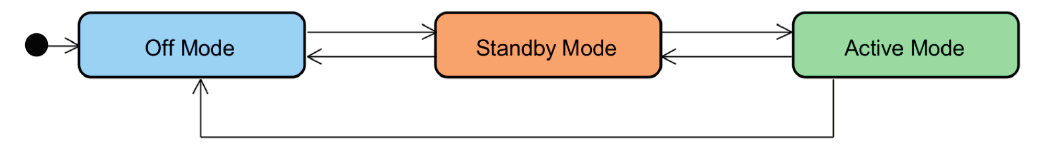
Figure 5. Three-Mode interface model of an ACC